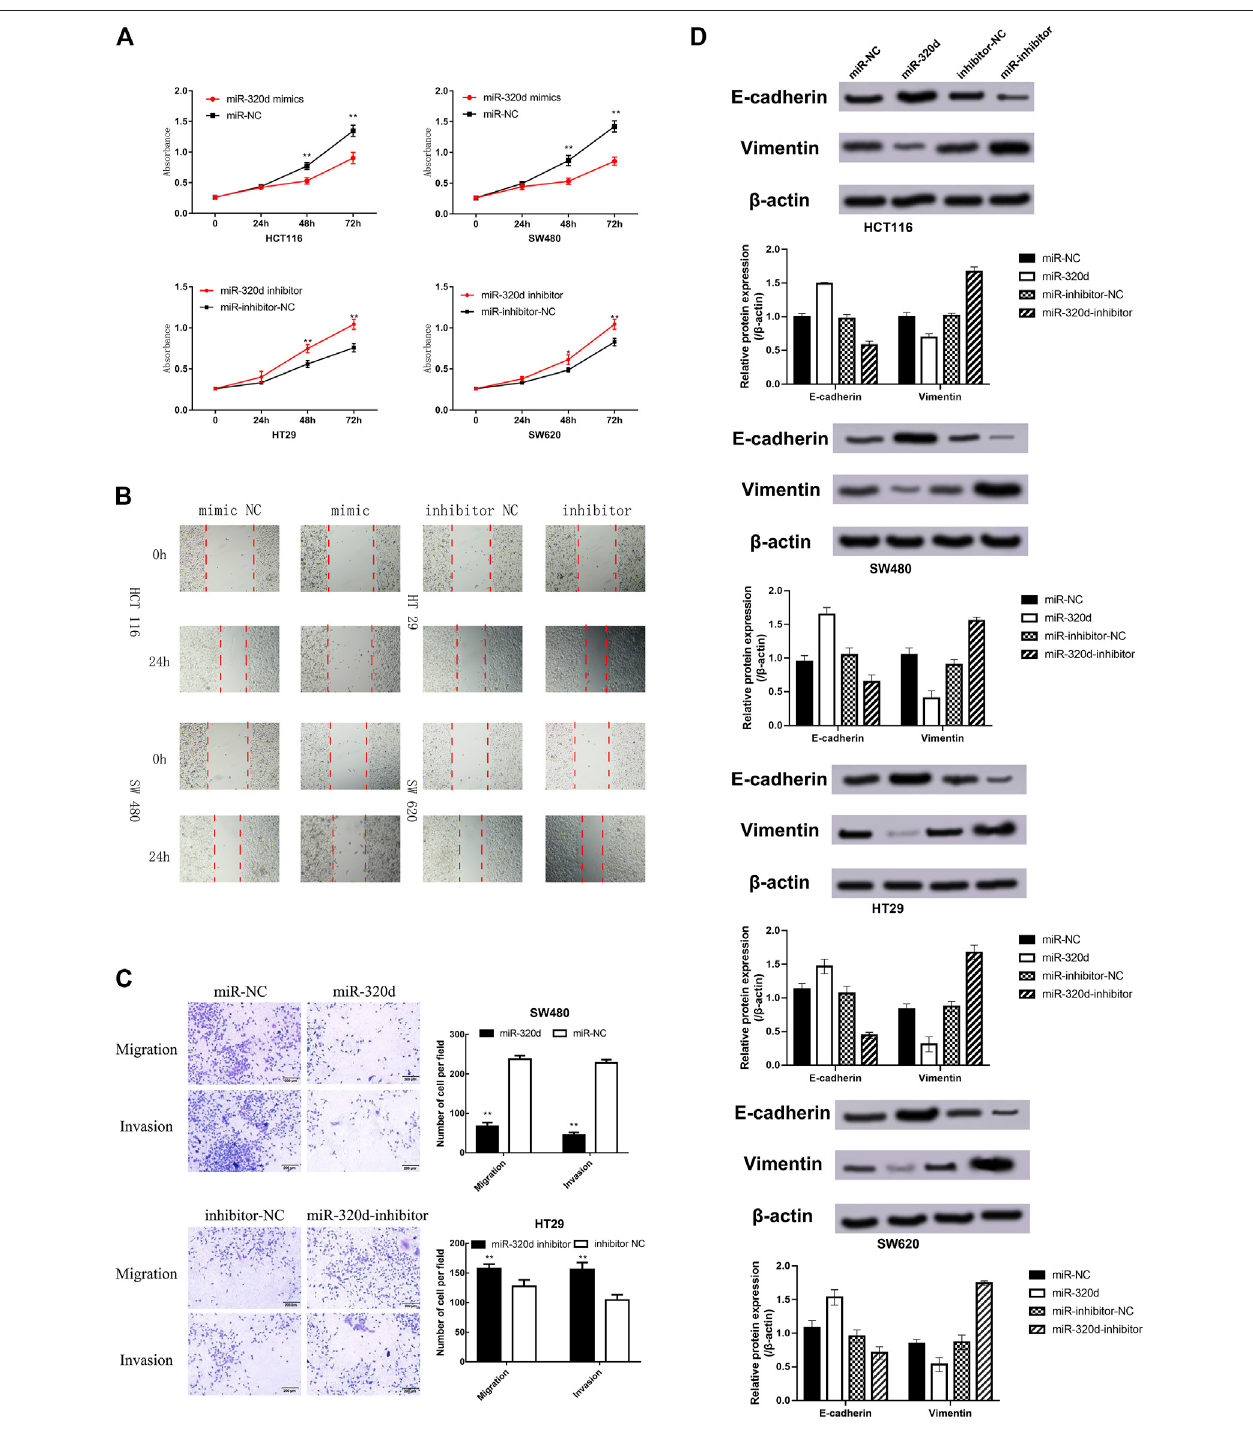
FIGURE3| EctopicexpressionofmiR-320dinhibitstheproliferation,invasion,andmigrationofEGFR-positiveCRCcells. (A) MTTcellproliferationassaysinEGFR- positive CRC cells transfected with indicated miRNAs. (B) Representative photomicrographs of wound-healing assay in EGFR-positive CRC cells after transfection of miRNAs. (C) TranswellassaysofEGFR-positiveCRCcellscarryingdifferentmiRNAs.Thetotalnumberofcellsinthe fi eldwascountedmanually.Assayswereperformed in triplicates. Mean ± SD is shown. Statistical analysis was conducted using one-way ANOVA. ** p < 0.01. (D) Western blots of E-cadherin and vimentin in EGFR- positive CRC cells transfected with different miRNAs.; Abbreviations: MTT, 3-(4,5-dimethylthiazol-2-yl)-2, 5-diphenyltetrazolium bromide; NC, negative control.